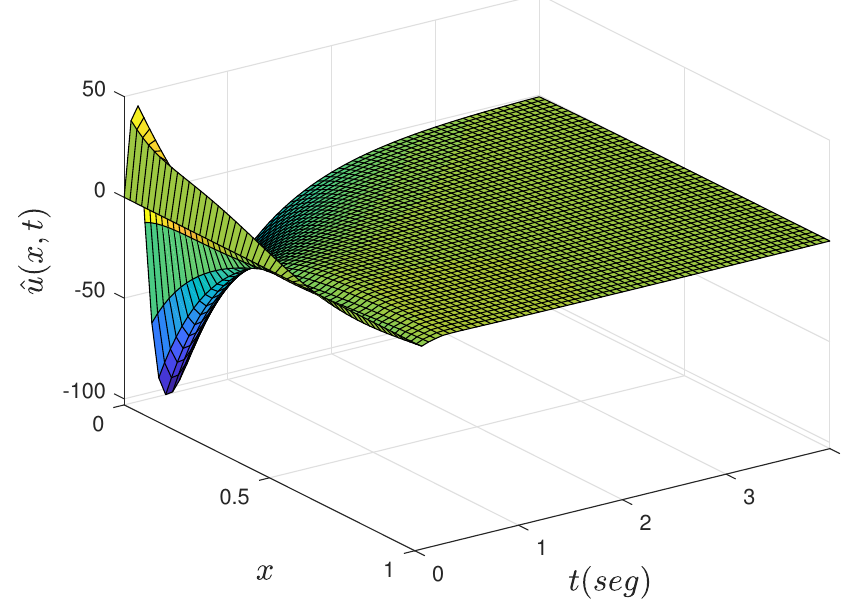
Figure 9. Dynamics of the identifier